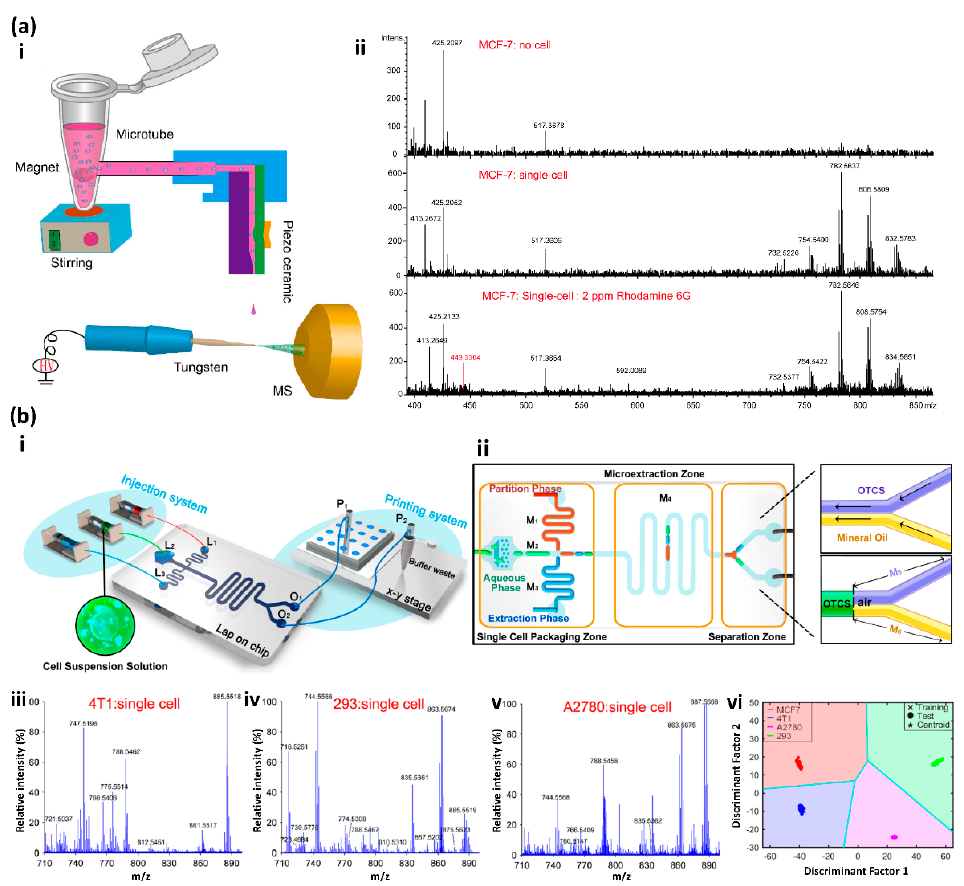
Figure 6. ( a-i ) Schematic illustration of the experiment setup: ( a - ii ) Detection of the single MCF cell labeled with Rhodamine 6G. Reproduced with permission from [113]. ( b-i ) Schematic illustration of the three-phase single-cell printing (TP-SCP) system. ( b - ii ) Schematic diagram of the microfluidic chip with the three functional zones. ( b-iii–b-v ) MS spectra of ( b - iii ) 4T1 single cells, ( b - iv ) 293 single cells and ( b - v ) A2780 single cells. ( b - vi ) The classification result of the four types of cells. Reproduced with permission from [110].